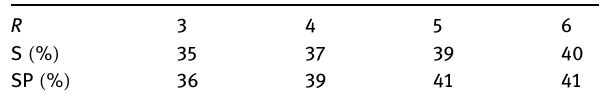
Table 6: Crystallinity degree of X c of PVDF - HFP stretched fi lms at various elongation ratios ( T p = 40°C )